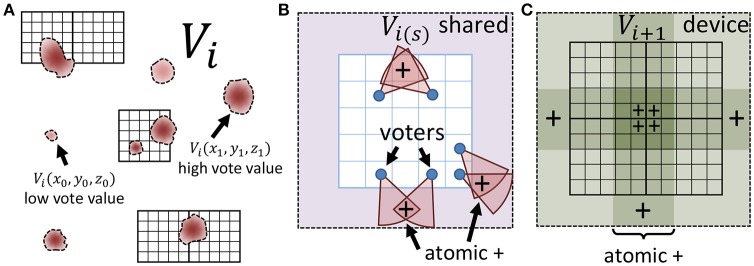
Minimizing memory latency and write conflicts. (A) The vote image V at iteration i is mapped to a CUDA grid composed of square thread blocks. (B) Each thread block writes votes to shared memory using atomic adds to ensure that simultaneous votes (+) are correctly cast. (C) The shared region for each block is copied to global memory using atomic operations to ensure that votes from adjacent blocks (+) are cast correctly.